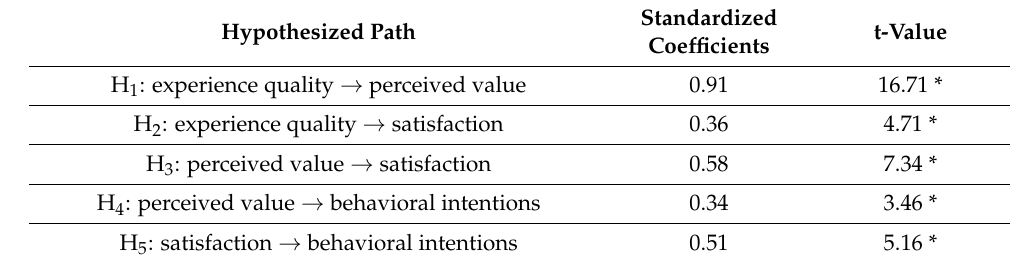
Figure 1. Hypothetical Model Testing Results. Table 3. Results of the proposed model.